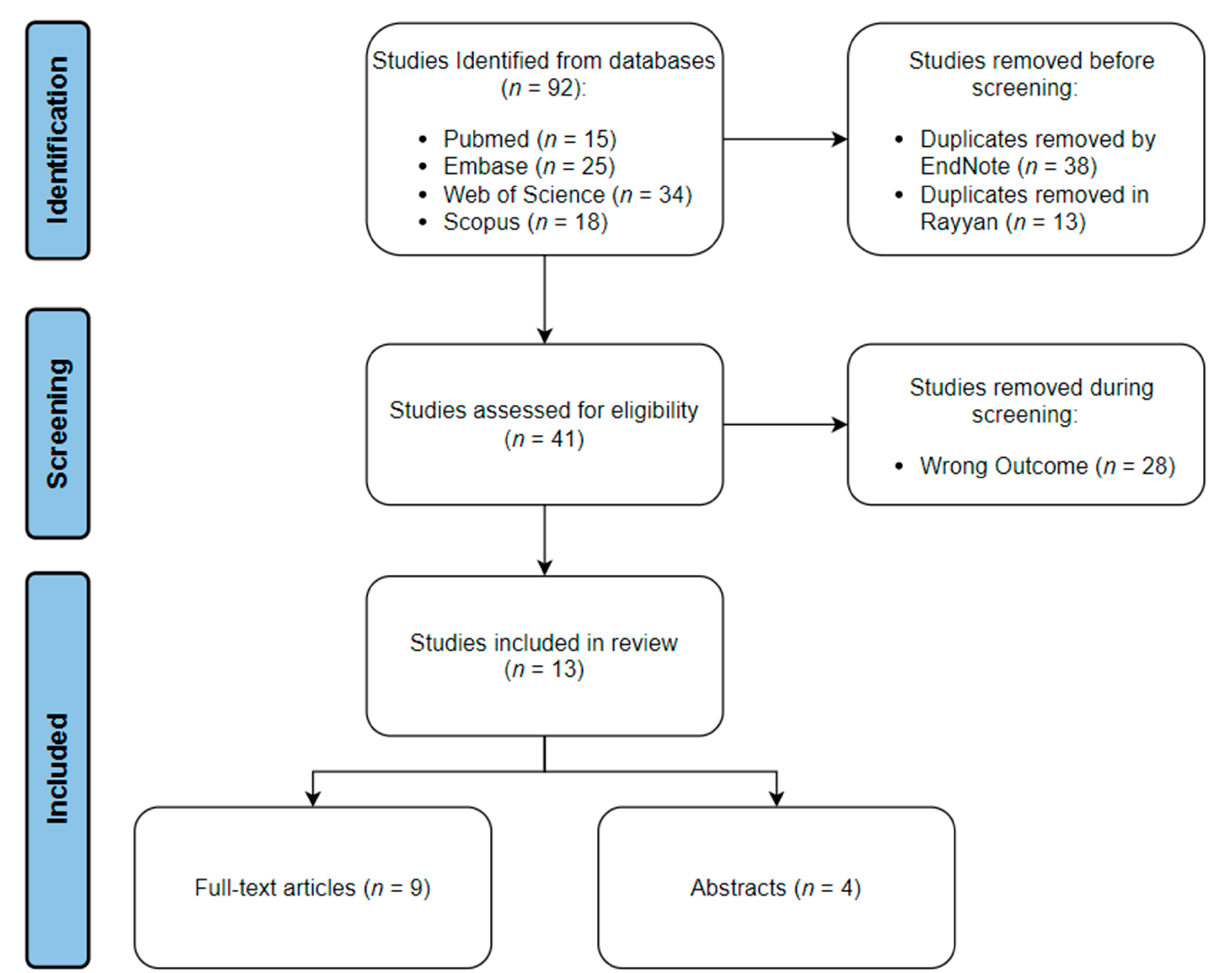
Figure 1. Schematic representation of review process.